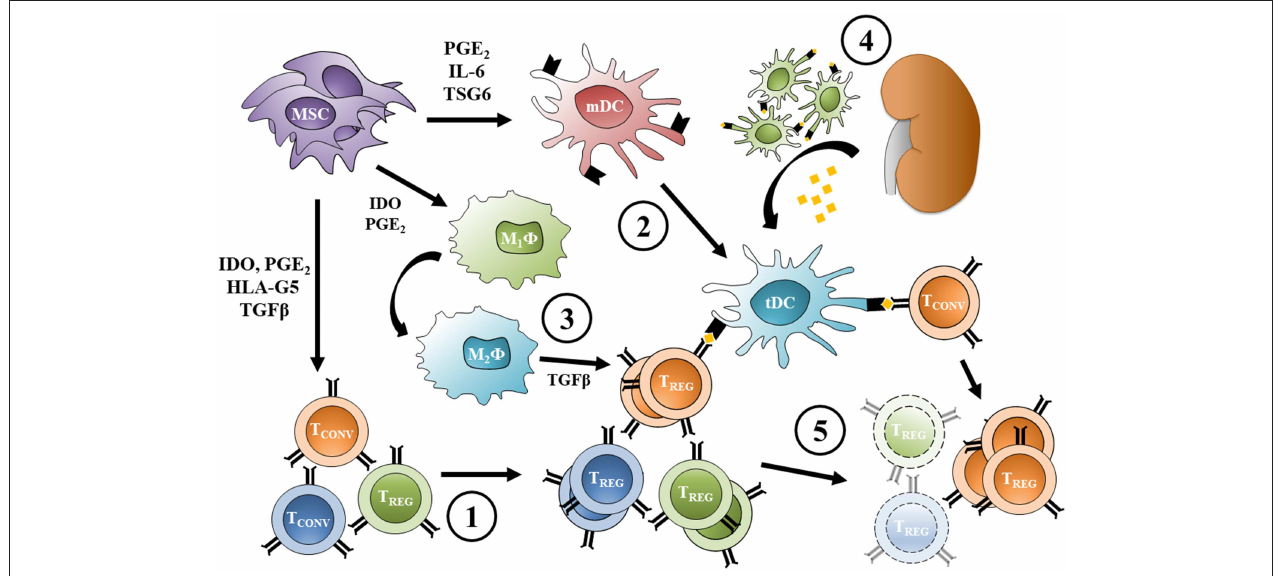
FIGURE 1 | Expansion of donor-specific T REG following pre-transplant MSC infusion. (1) MSC infused before transplant induce T REG from conventional T cells and promote a polyclonal, antigen-independent expansion; at the same time, (2) MSC inhibit dendritic cell maturation increasing the frequency of protolerogenic DCs, and (3) reprogram macrophages toward an M 2 phenotype. (4) Allogeneic transplantation causes migration of donor DCs from the graft to lymphoid organs and provides alloantigen for recipient DC uptake (other antigen presenting cells can act the same way). (5) Direct and indirect antigen presentation provide the survival stimuli necessary for donor-specific T REG proliferation, while the non-alloreactive T REG pool is progressively lost over time. Protolerogenic DCs can also induce T REG from conventional alloreactive T cells, while alternatively-activated macrophage TGF β secretion promotes T REG expansion. MSC, mesenchymal stromal cell; T CONV , conventional T cell; T REG , regulatory T cell; mDC, mature dendritic cell; tDC, tolerogenic dendritic cell; M 1 φ , classically-activated macrophage; M 2 φ , alternatively-activated macrophage; PGE2, prostaglandin-E 2 ; IDO, indoleamine 2,3-dioxygenase; TGF β , transforming growth factor β ; HLA-G5, human leukocyte antigen G5; IL-6, interleukin 6; TSG6, tumor necrosis factor-inducible gene 6 protein.